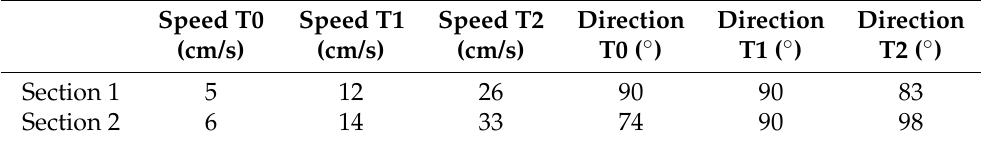
Table 5. Speed of movement of targets T0, T1 and T2 during the third release.